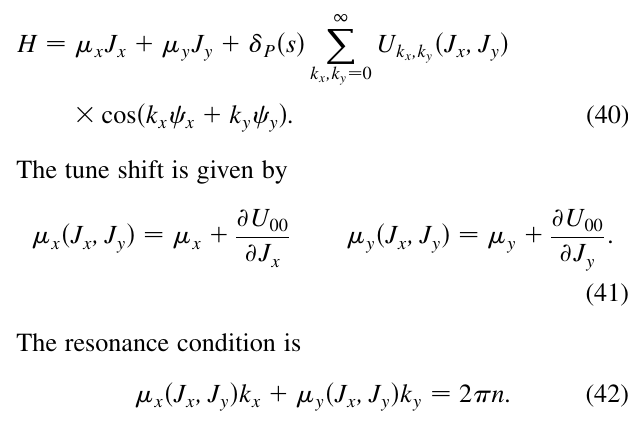
phase space motion. Plots (a) and (b) depict tune variation for r plots to (a) and (b), r